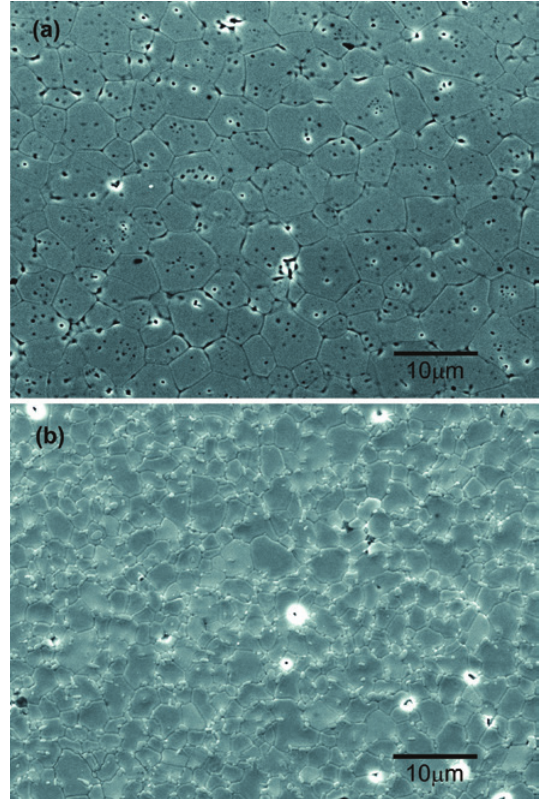
Fig. 1: SEM micrographs of undoped and 1 wt% CuO-doped 8YSZ specimens sintered at 1400 °C for 10